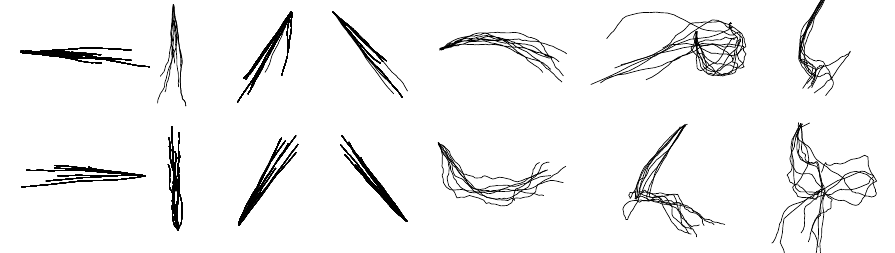
Figure 5. The randomly selected reconstructed drawing traces of with-group reconstruction by the KF-GEP. The shapes are, from left to right, in order, horizontal line, vertical line, forward slash, backslash, arch, circle, ellipse, reversed horizontal line, reversed vertical line, reversed forward slash, reversed backslash, reversed arch, square and triangle.